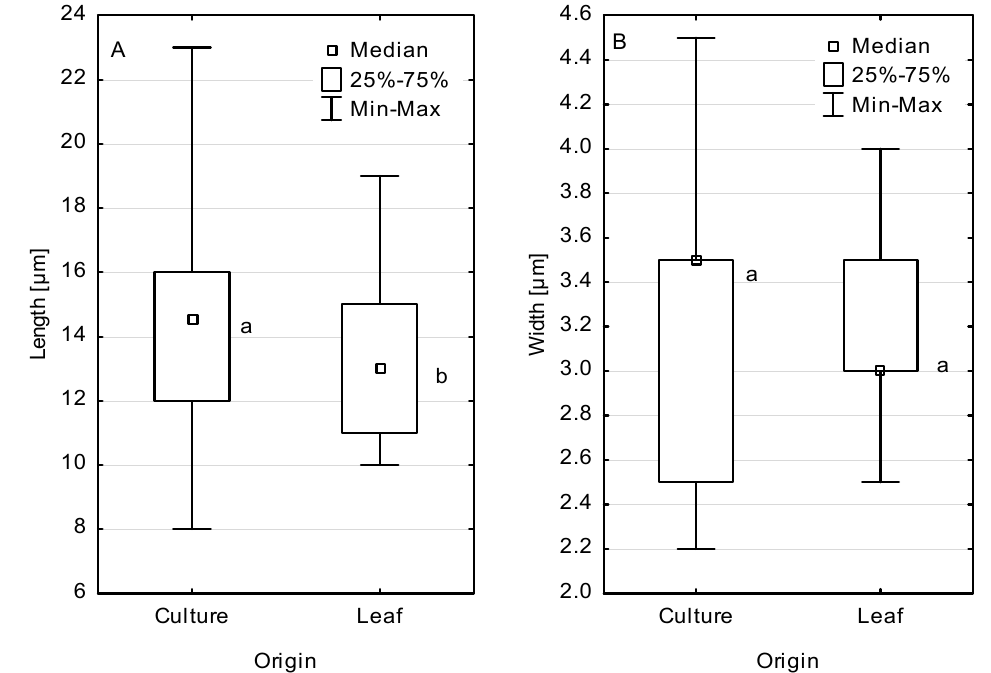
Figure 4. Length ( A ) and width ( B ) of Apiognomonia hystrix macroconidia produced in cultures and in necroses on leaves. Groups indicated with different letters in Mann–Whitney U test are significantly different at α = 0.05.